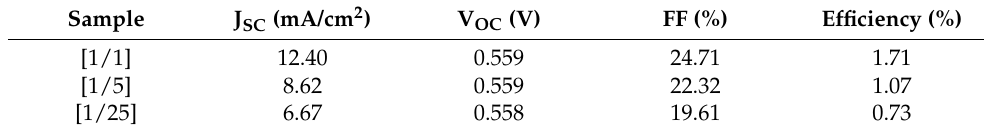
Table 6. Performance of CIGS solar cells with various Thiourea concentrations.